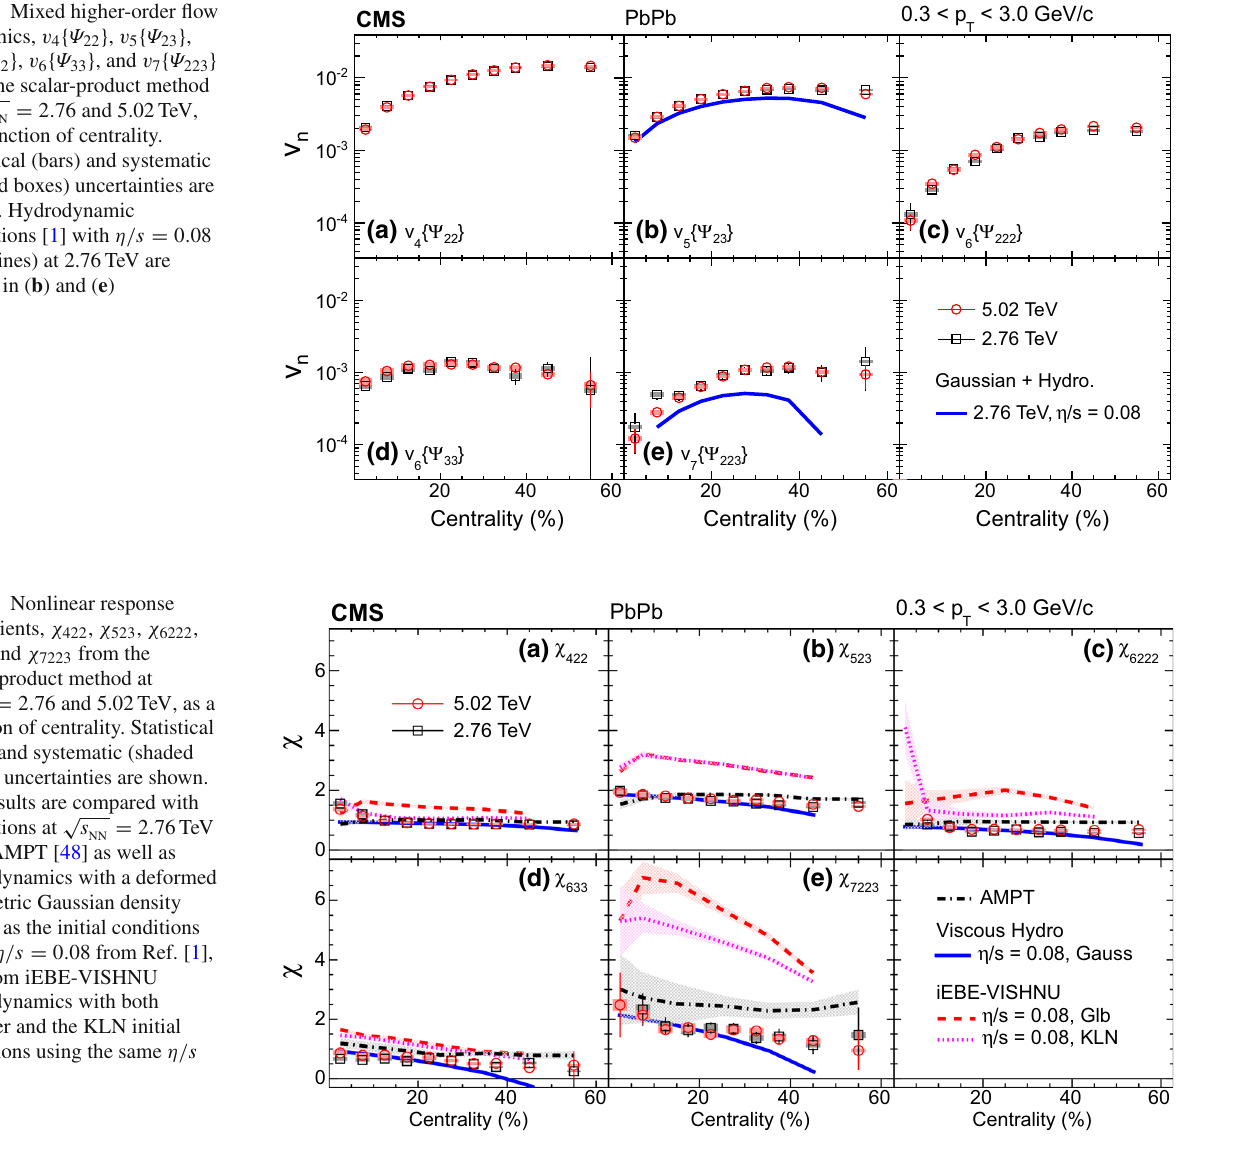
Fig. 4 Mixed higher-order flow harmonics, v 4 { Ψ 22 } , v 5 { Ψ 23 } , v { Ψ } , v { Ψ } , and v { Ψ } 6 222 6 33 7 223 from the scalar-product method √ = 2 . 76 and 5.02TeV, s at NN as a function of centrality. Statistical (bars) and systematic (shaded boxes) uncertainties are shown. Hydrodynamic predictions [1] with η/ s = 0 . 08 (blue lines) at 2.76TeV are shown in ( b ) and ( e )